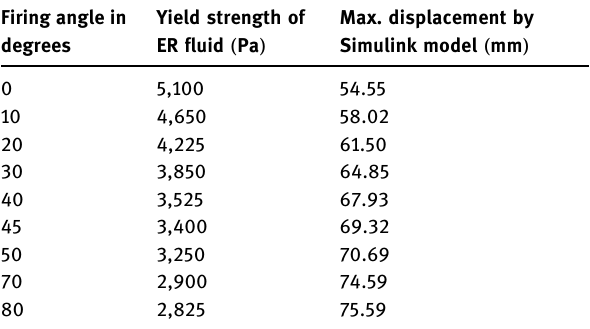
Table 2: Displacement and yield strength at di ff erent fi ring angles Firing angle in degrees